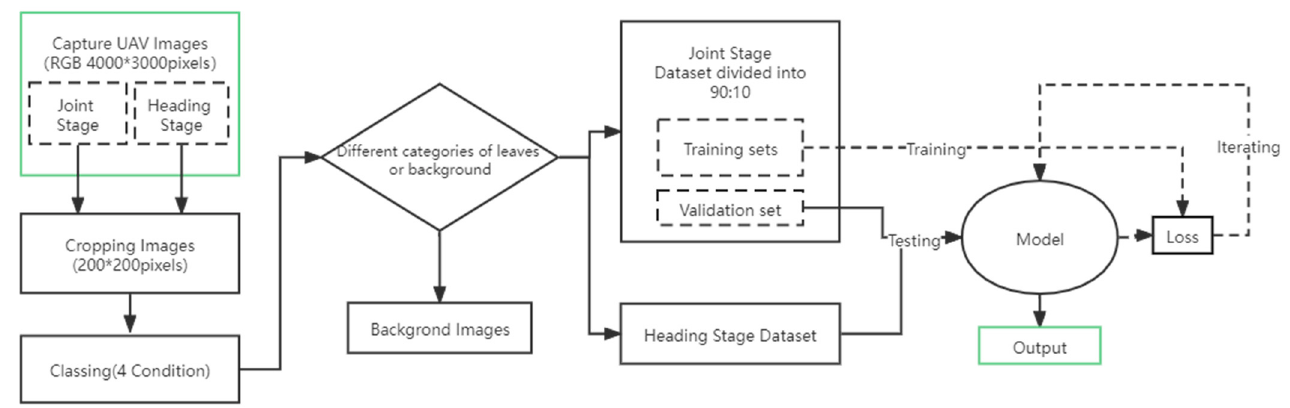
Figure 7. Illustration of the process used in this study.